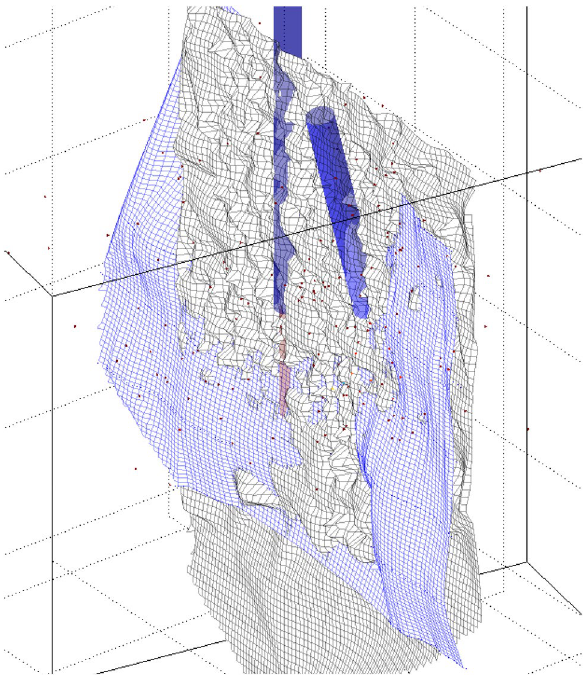
Fig. 13 Zoomed comparison between the AE predicted hydraulic fracture (black) and the digitized fracture location from the slab pho- tos (blue)